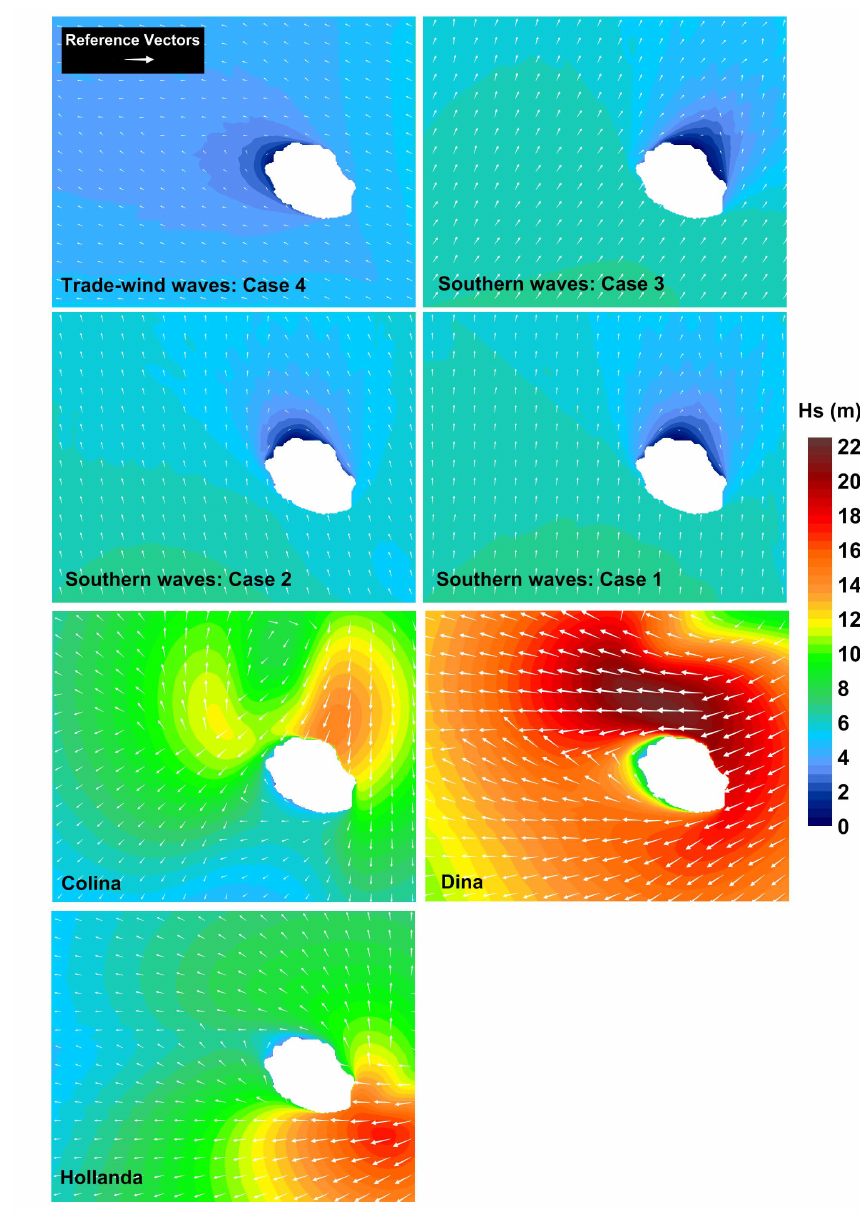
Fig. 10. Wave fields modelled with SWAN for each scenario at grid R1. For the cyclonic scenarios (performed with a transitional mode), the figure corresponds to the peak of the waves near Reunion Island. The colour bar indicates the amplitude of H s and the vectors indicate wave